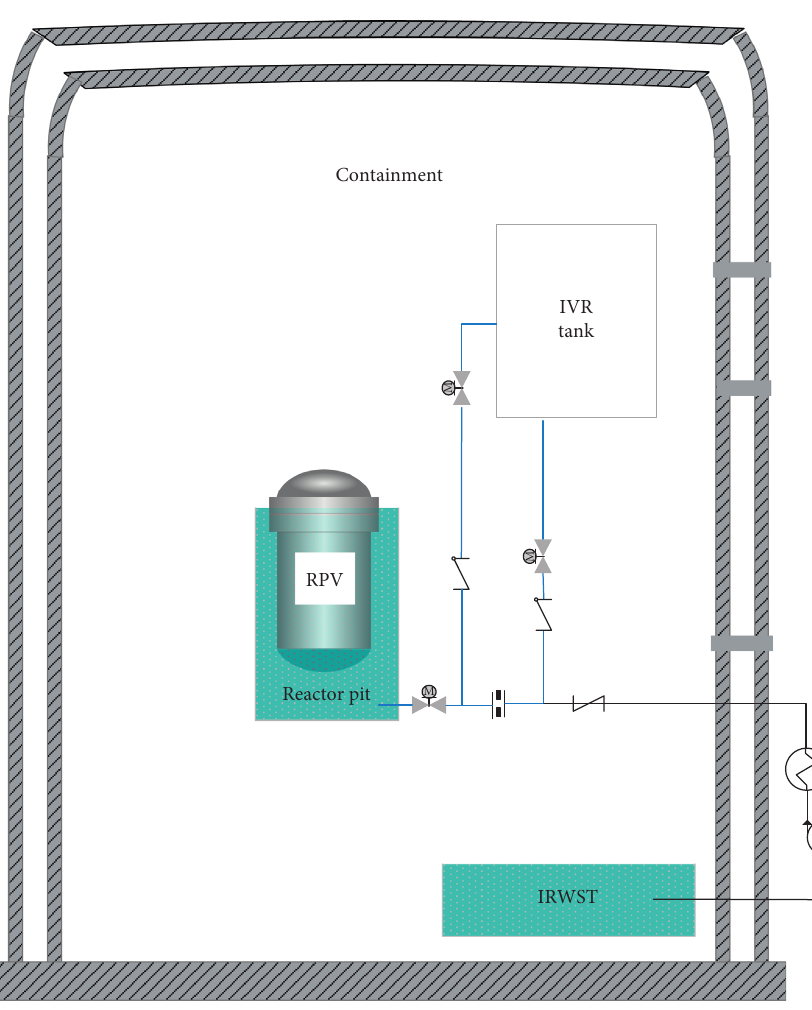
Figure 1: Design scheme of reactor pit flooding system.